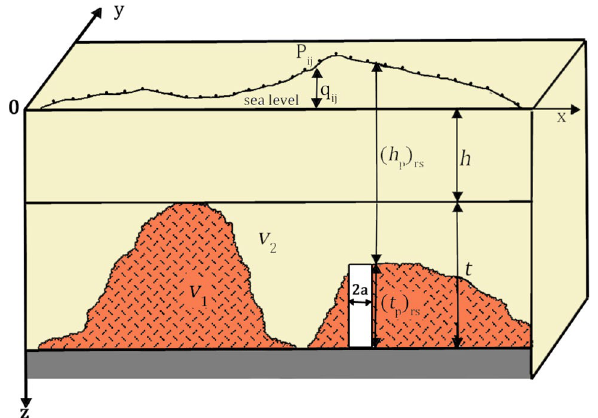
Figure 9. Sketch model of an interface separating two media producing a density contrast v = v 1 − v 2 . The model is composed of a set of prisms with a lateral extent of 2a and thickness